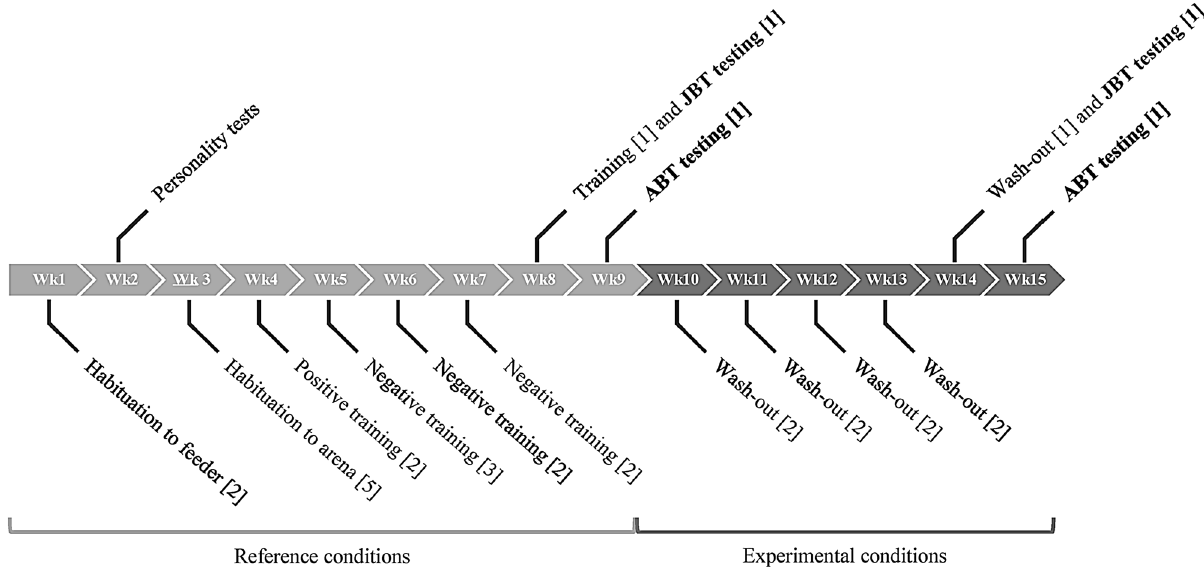
Figure 1. Timeline of the experimental procedures during each batch. Habituation, training and wash-out sessions were part of the Judgement Bias Task (JBT). Numbers in square brackets indicate the number of sessions conducted per heifer per week on weekdays. If necessary, additional sessions were added during the weekends or during the evenings. Testing sessions of the JBT and the Attention Bias Task (ABT) are indicated in bold. Weeks in light grey (week 1–week 9) depict the reference conditions, while weeks in dark grey depict the experimental conditions. Heifers were housed under stable housing conditions during the reference conditions; while they were housed under supposedly weekly-improved or weekly-worsened conditions during the experimental